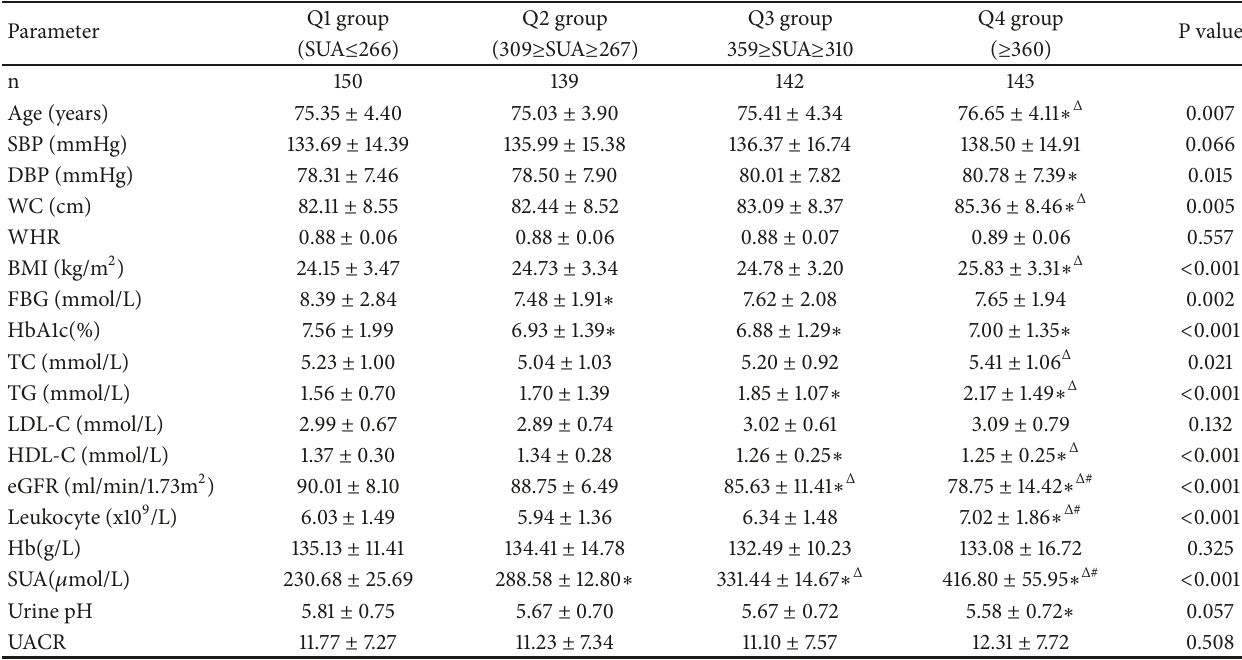
Table 3: Clinical data in female patients according to SUA